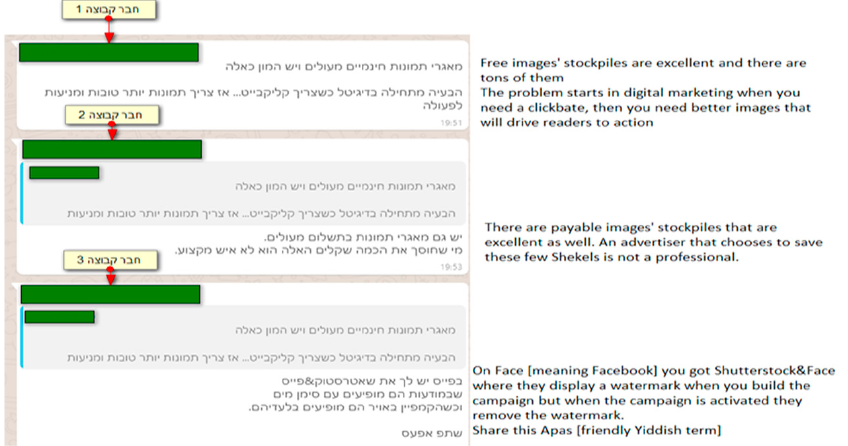
Figure 1. A thread discussing advertising practices in a Haredi vocational group.